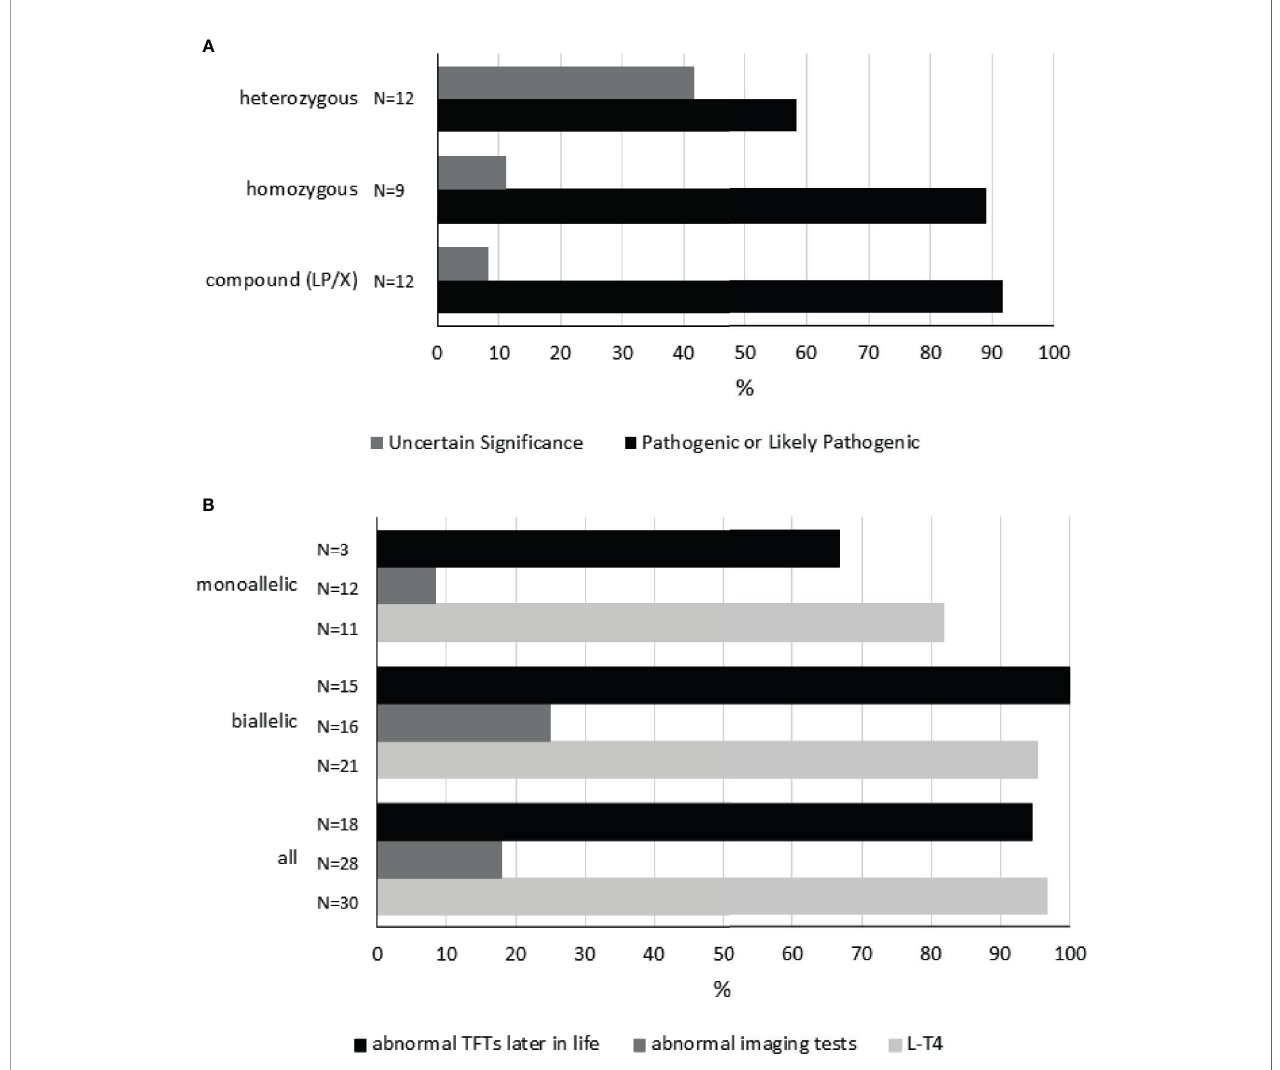
FIGURE 3 | Genetic variation in the TSHR gene. Panel (A) shows each reported genotype [compound heterozygous (LP/X), homozygous and heterozygous] representing a cluster. As disease severity will depend on the combination of variants in every locus, variants were interpreted and classi fi ed (see Table S6 ). Within each cluster, the percentages of each combination of sequence variants are shown. “ Pathogenic ” and “ Likely Pathogenic ” were grouped together. Panel (B) shows 1) the percentage of subjects receiving L-T4 therapy, 2) the percentage of cases showing abnormal imaging tests, and 3) the percentage of individuals having abnormal TFTs later in life according to genotype. Compound heterozygous (LP/X) and homozygous genotypes were grouped together as biallelic. TFTs, thyroid- function tests. For details, please see Table S5